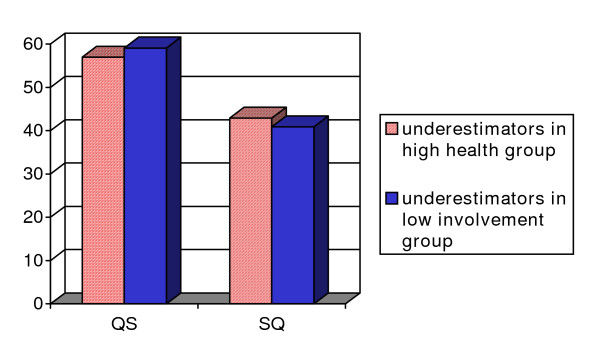
Percentages of underestimators among subgroupsa. aborderline significant differences (p < .10) in percentages.